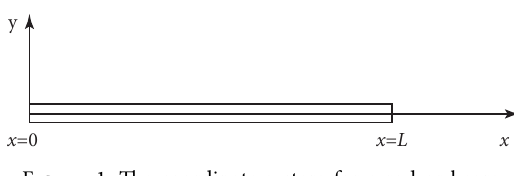
Figure 1: The coordinate system for a rod or